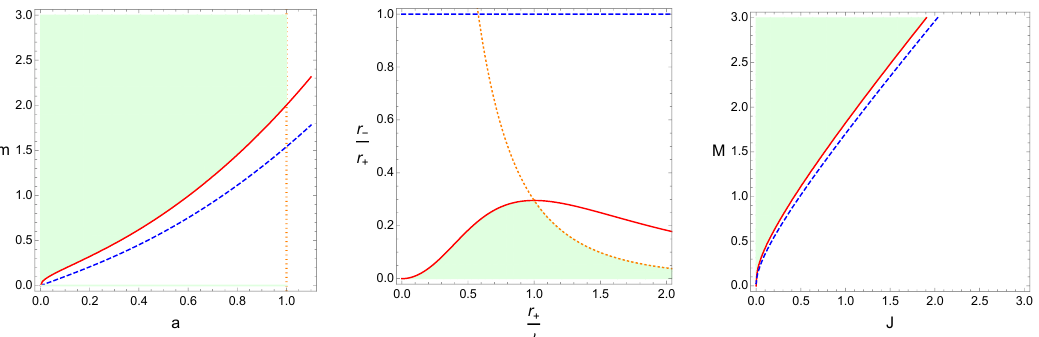
Figure 13 . In filled green the allowed region satisfying conditions 1)–3) in the space of parameters, (cid:16) (cid:17) r + both in the ( a, m ) -plane (left), , r − -plane (center), and ( J, M ) -plane (right) for ‘ = 1 . In the ‘ r + left panel, we also include the empty AdS 4 line of solutions with m = 0 in oblate coordinates. In dashed blue the extremality curve, in dotted orange the parameter singularity a = ‘ , in solid red the other instability bound r 2 = a ‘ +